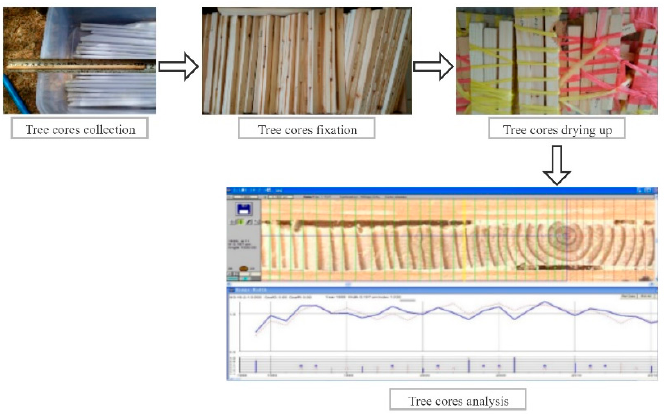
Figure 6. Flowchart of tree rings analysis.